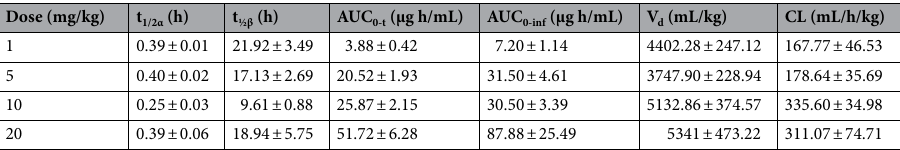
Table 2. Mean pharmacokinetic parameters of LLNL-02 ( 1 ) following a single IV administration of 14 C-LLNL-02 to male guinea pigs. Data is expressed as the mean of six animals ± the standard error.